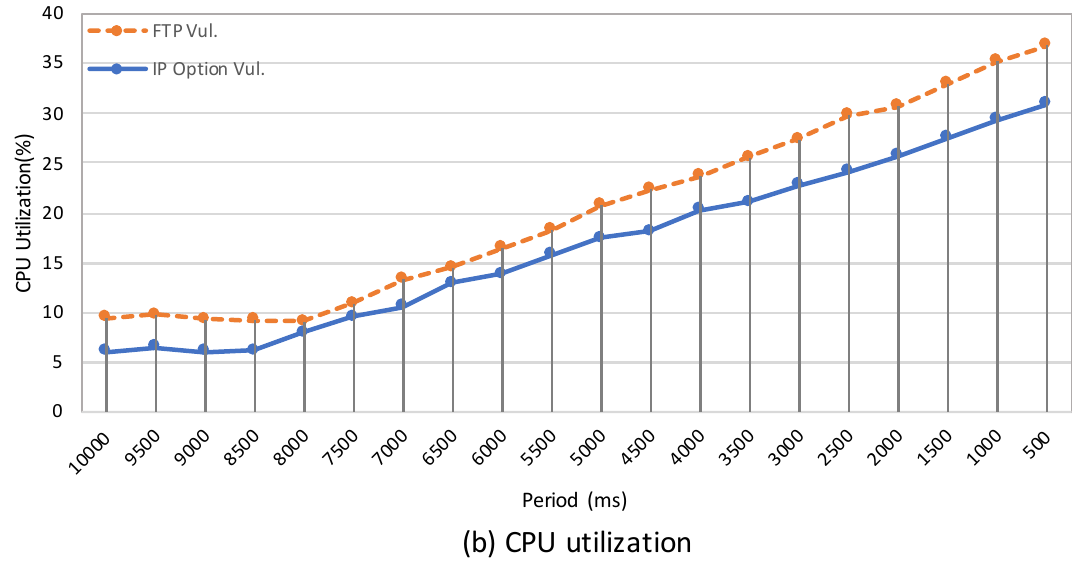
Figure 4. Experimental